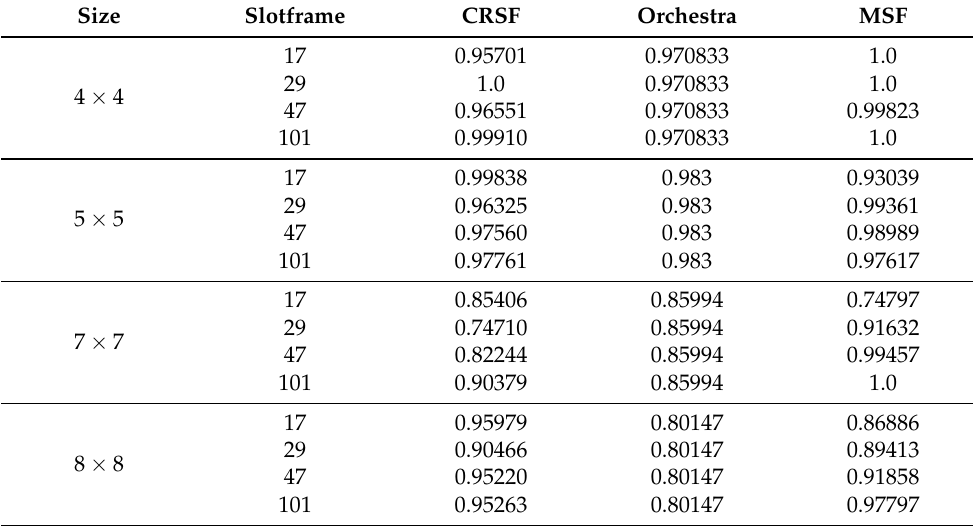
Table A5. Results for the PDR with a burst traffic pattern.